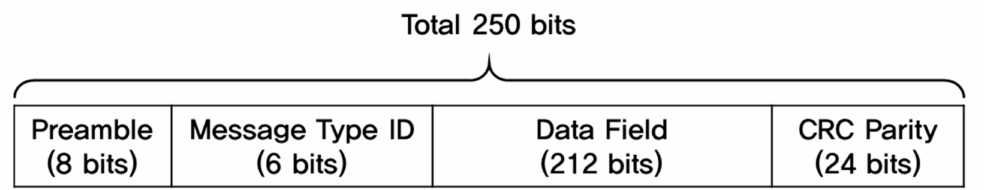
Figure 2. SBAS message structure